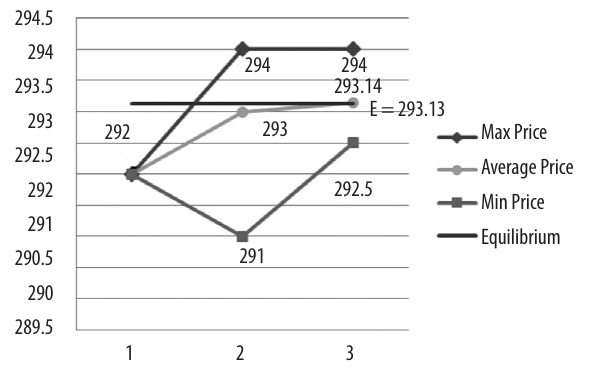
Fig 4. Final prices of Game 3 for each